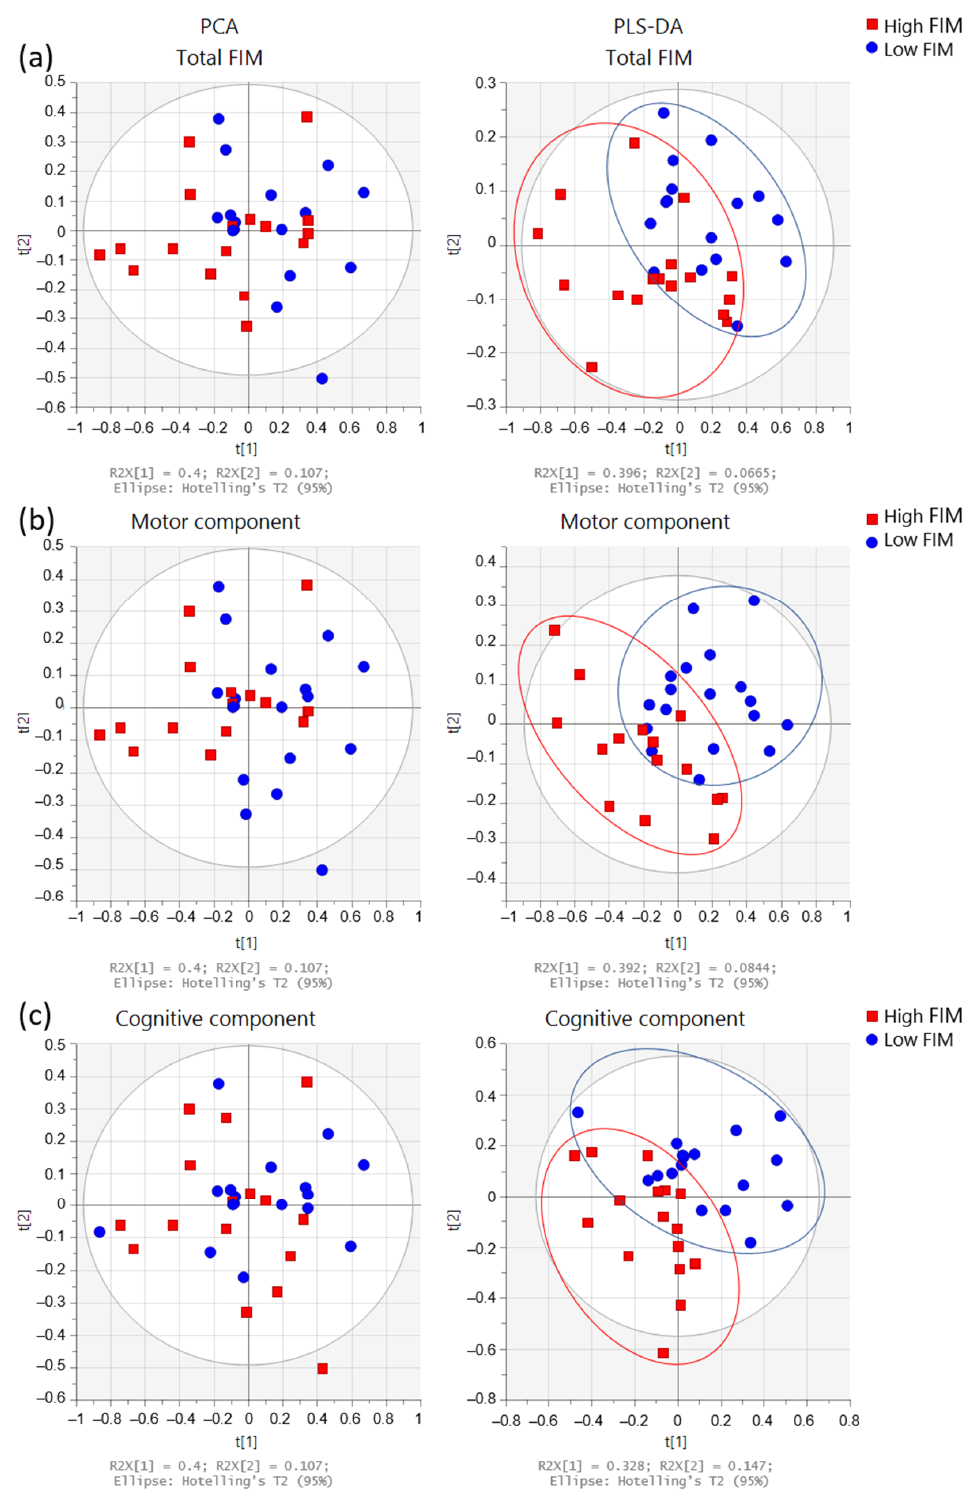
Figure 4. Multivariate analysis obtained from the urine spectra of the participants (n = 33). Score plots from the PCA ( left side) and PLS-DA ( right side) for FIM scores: Comparisons between ( a ) total FIM: low ≤102 (n = 16) and high >102 (n = 17); ( b ) motor component: low ≤74 (n = 18) and high >74 (n = 15), and ( c ) cognitive component: low ≤31 (n = 17) and high >31 (n = 16). FIM groups were dichotomized by medians: high FIM (red squares) and low FIM (blue circles).